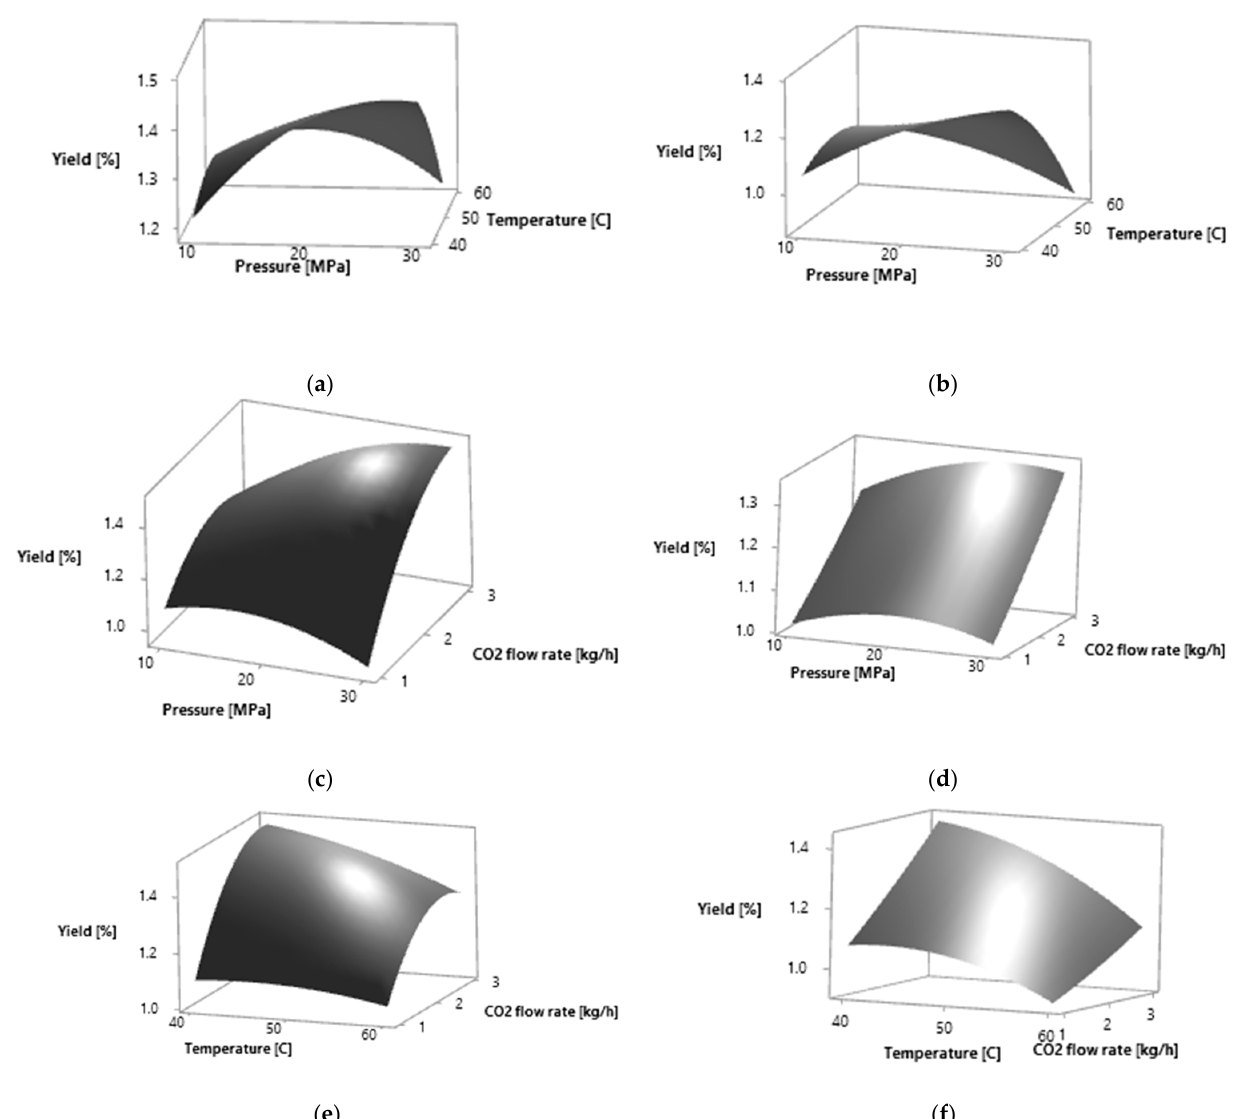
Figure 1. Response surfaces for effects of two independent variables on the extraction yield of P. persica leaves by SC CO 2 extraction: ( a ) pressure (MPa) and temperature (°C) for yellow leaves; ( b ) pressure (MPa) and temperature (°C) for amber leaves; ( c ) pressure (MPa) and CO 2 flow rate (kg·h − 1 ) for yellow leaves; ( d ) pressure (MPa) and CO 2 flow rate (kg·h − 1 ) for amber leaves; ( e ) temperature (°C) and CO 2 flow rate (kg·h − 1 ) for yellow leaves; ( f ) temperature (°C) and CO 2 flow rate (kg·h − 1 ) for amber leaves.